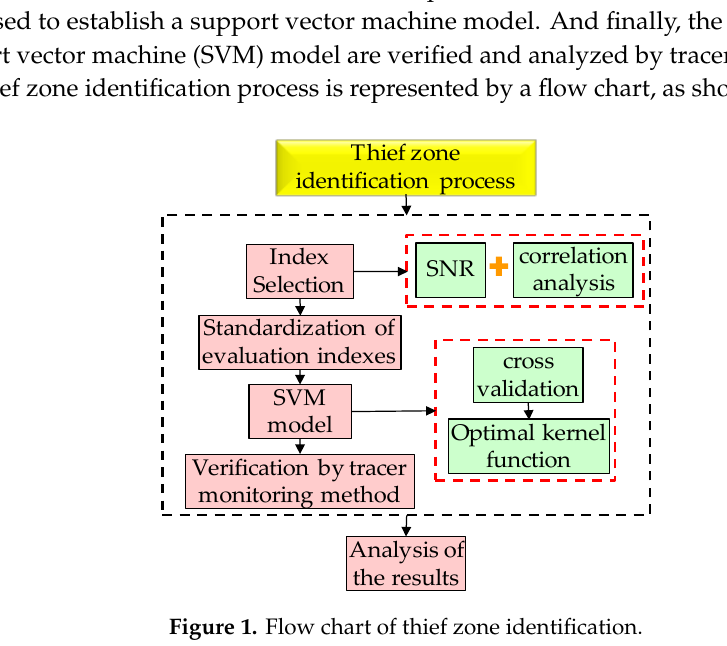
Figure 1. Flow chart of thief zone identification.